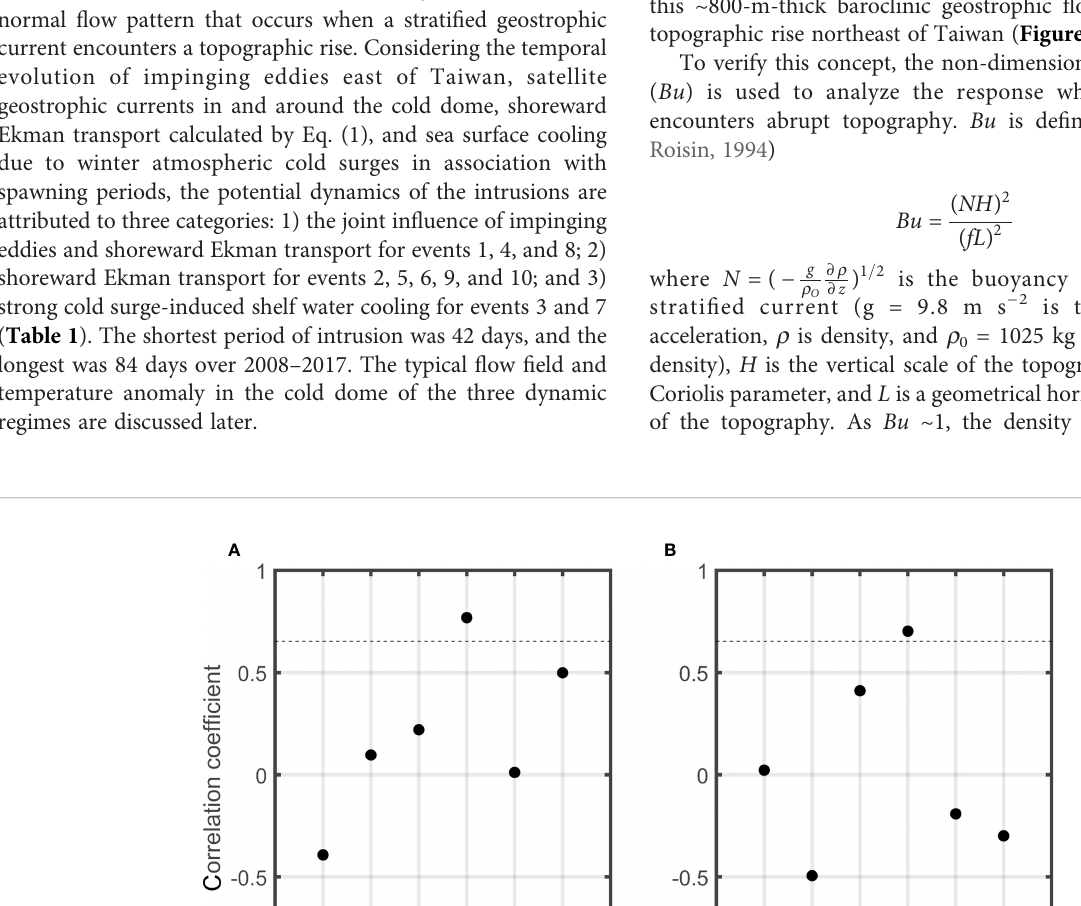
FIGURE 5 | Correlation coef fi cients of the standardized annual CPUE of swordtip squid over 2009 – 2017 and monthly mean seawater temperature at Peng-jia-yu isle for (A) July – December in the previous year over 2008 – 2016 and (B) January – June in the year over 2009 – 2017. The dashed lines mark the 95% con fi dence level.